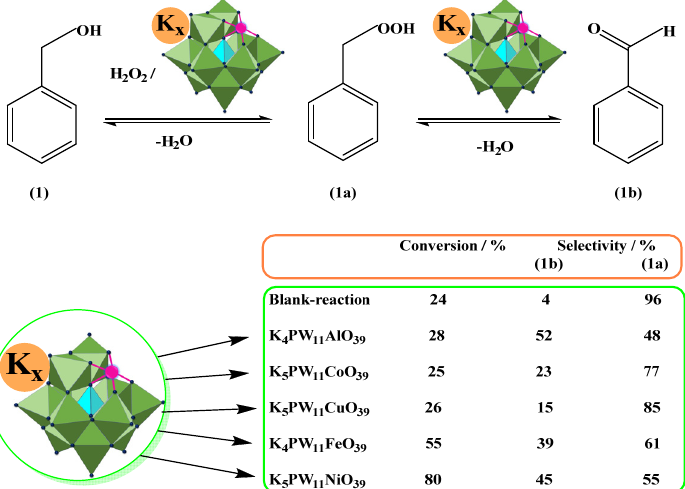
Figure 16. Benzylic alcohol oxidation with hydrogen peroxide over aluminium or transition metal- doped lacunar phosphotungstic acid potassium salts (adapted from ref. [30].